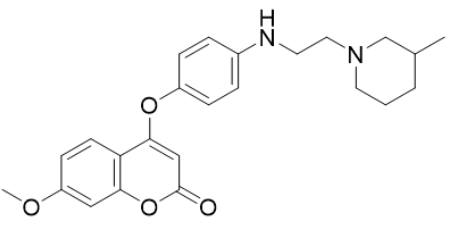
Figure 6. Chemical structure of N- (4-((2-((2-oxo-2 H -chromen-4-yl)oxy)phenyl)-2-(piperidin-1-yl)ac- etamide.